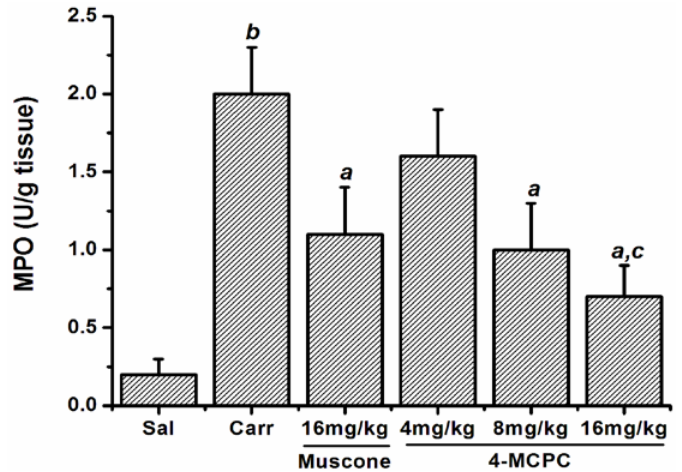
Figure 3. Effects of 4-MCPC on MPO activity in carrageenan-induced mouse paws. MPO activity was evaluated at 5 h after injection of carrageenan. MPO activity was reduced by 4-MCPC (8 and 16 mg/kg) and muscone (16 mg/kg). Bars represent mean ± SD for samples from six paws in each group. a p < 0.01 versus carrageenan group; b p < 0.01 versus saline control group; c p < 0.05 versus muscone group. Sal: saline; Carr: